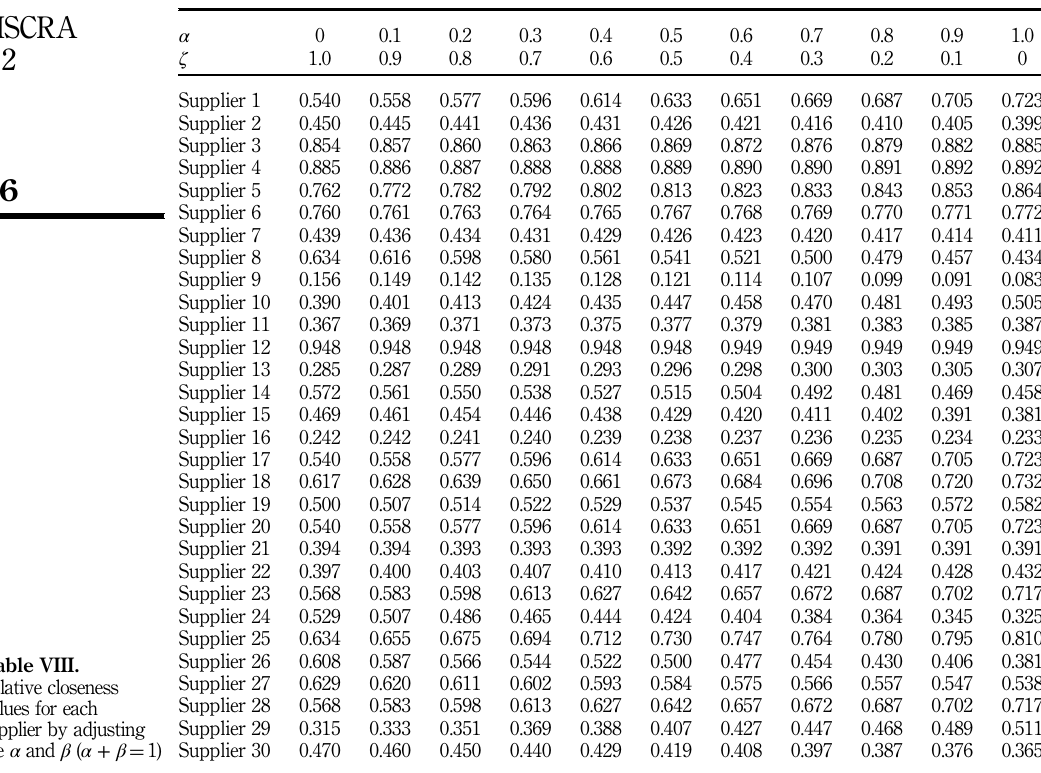
Table VIII. Relative closeness values for each supplier by adjusting the α and β ( α + β ¼